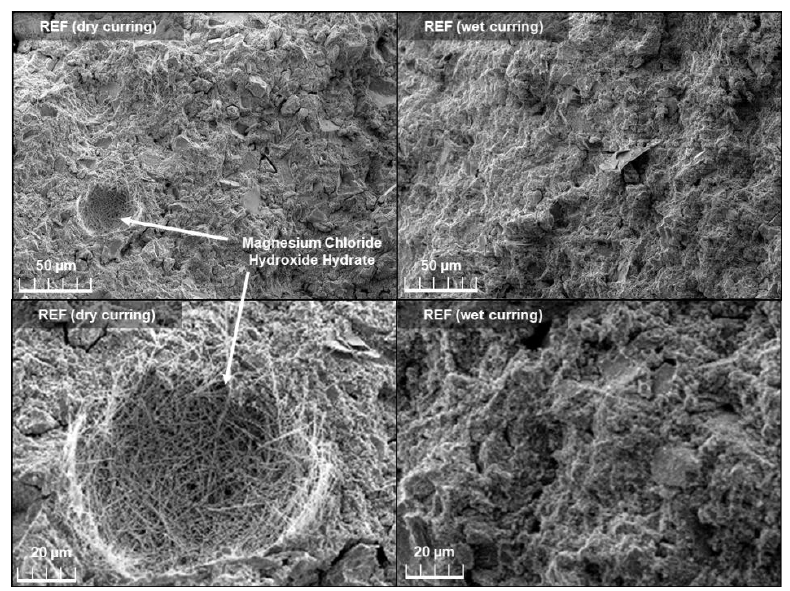
Figure 6. Microstructure of REF sample on Day 28 after wet and dry curing studied by SEM.